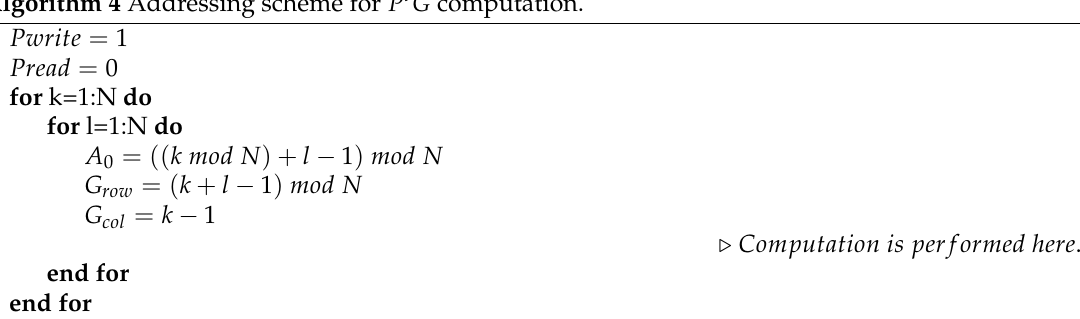
Algorithm 4 Addressing scheme for P t G